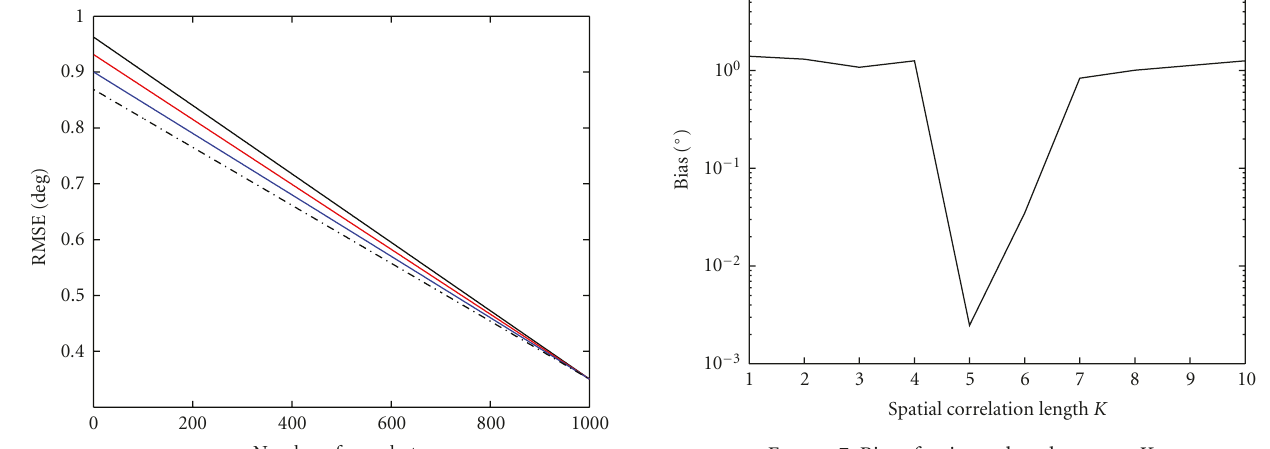
Figure 7: Bias of estimated angles versus K .